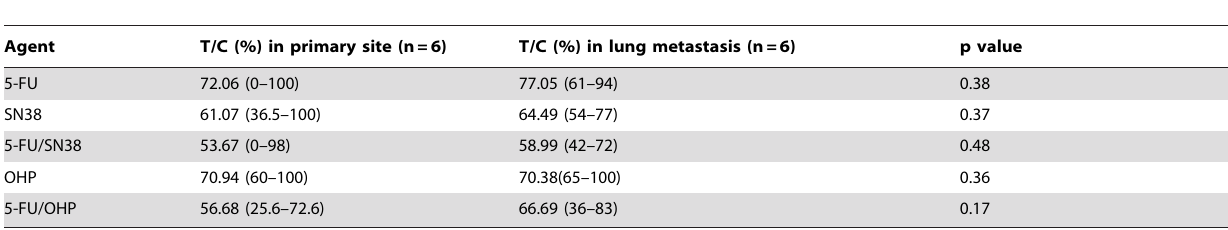
Table 5. Comparison of chemosensitivity between primary site and lung metastasis in CD-DST.